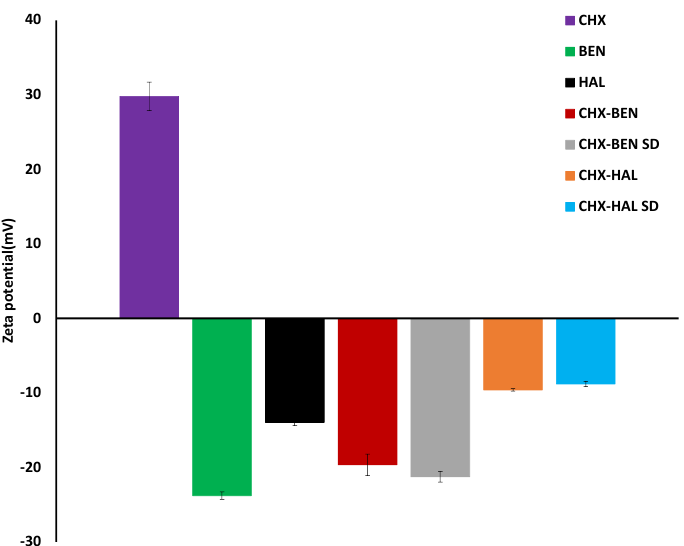
Figure 9. Values of ζ - – potential of nanohybrids and pristine components (mean values ± s.d.; n = 3). CHX: chlorhexidine dihydrochloride; BEN: bentonite; HAL: halloysite; CHX – BEN and CHX – HAL: nanohybrids obtained by intercalation solution technique; CHX – BEN SD and CHX – HAL SD: nanohybrids obtained by spray-drying